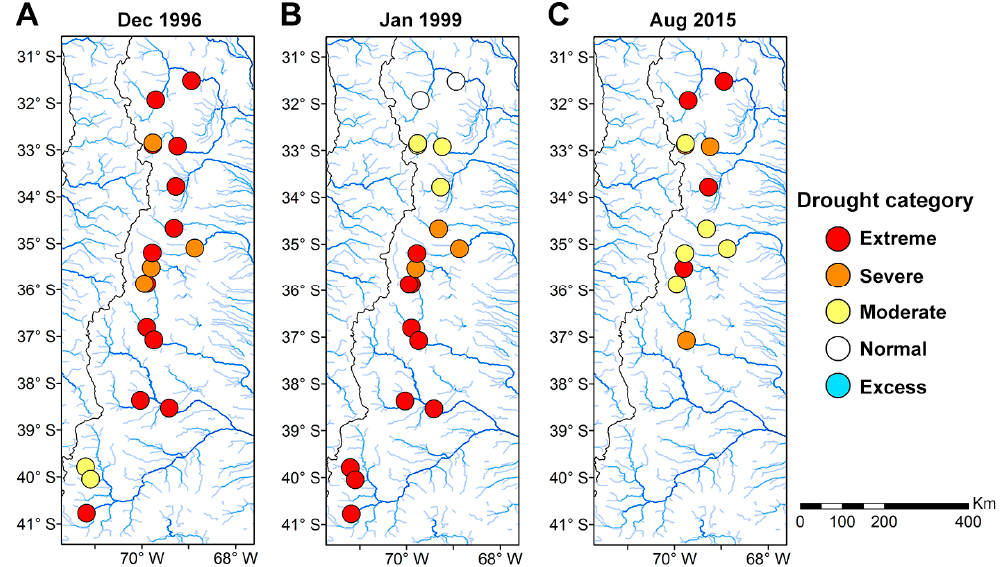
Figure 6. Spatial distribution patterns for the hydrological droughts according to drought categories during: December 1996 ( A ); January 1999 ( B ); and August 2015 ( C ). No data are available for the NP gauges during August 2015.